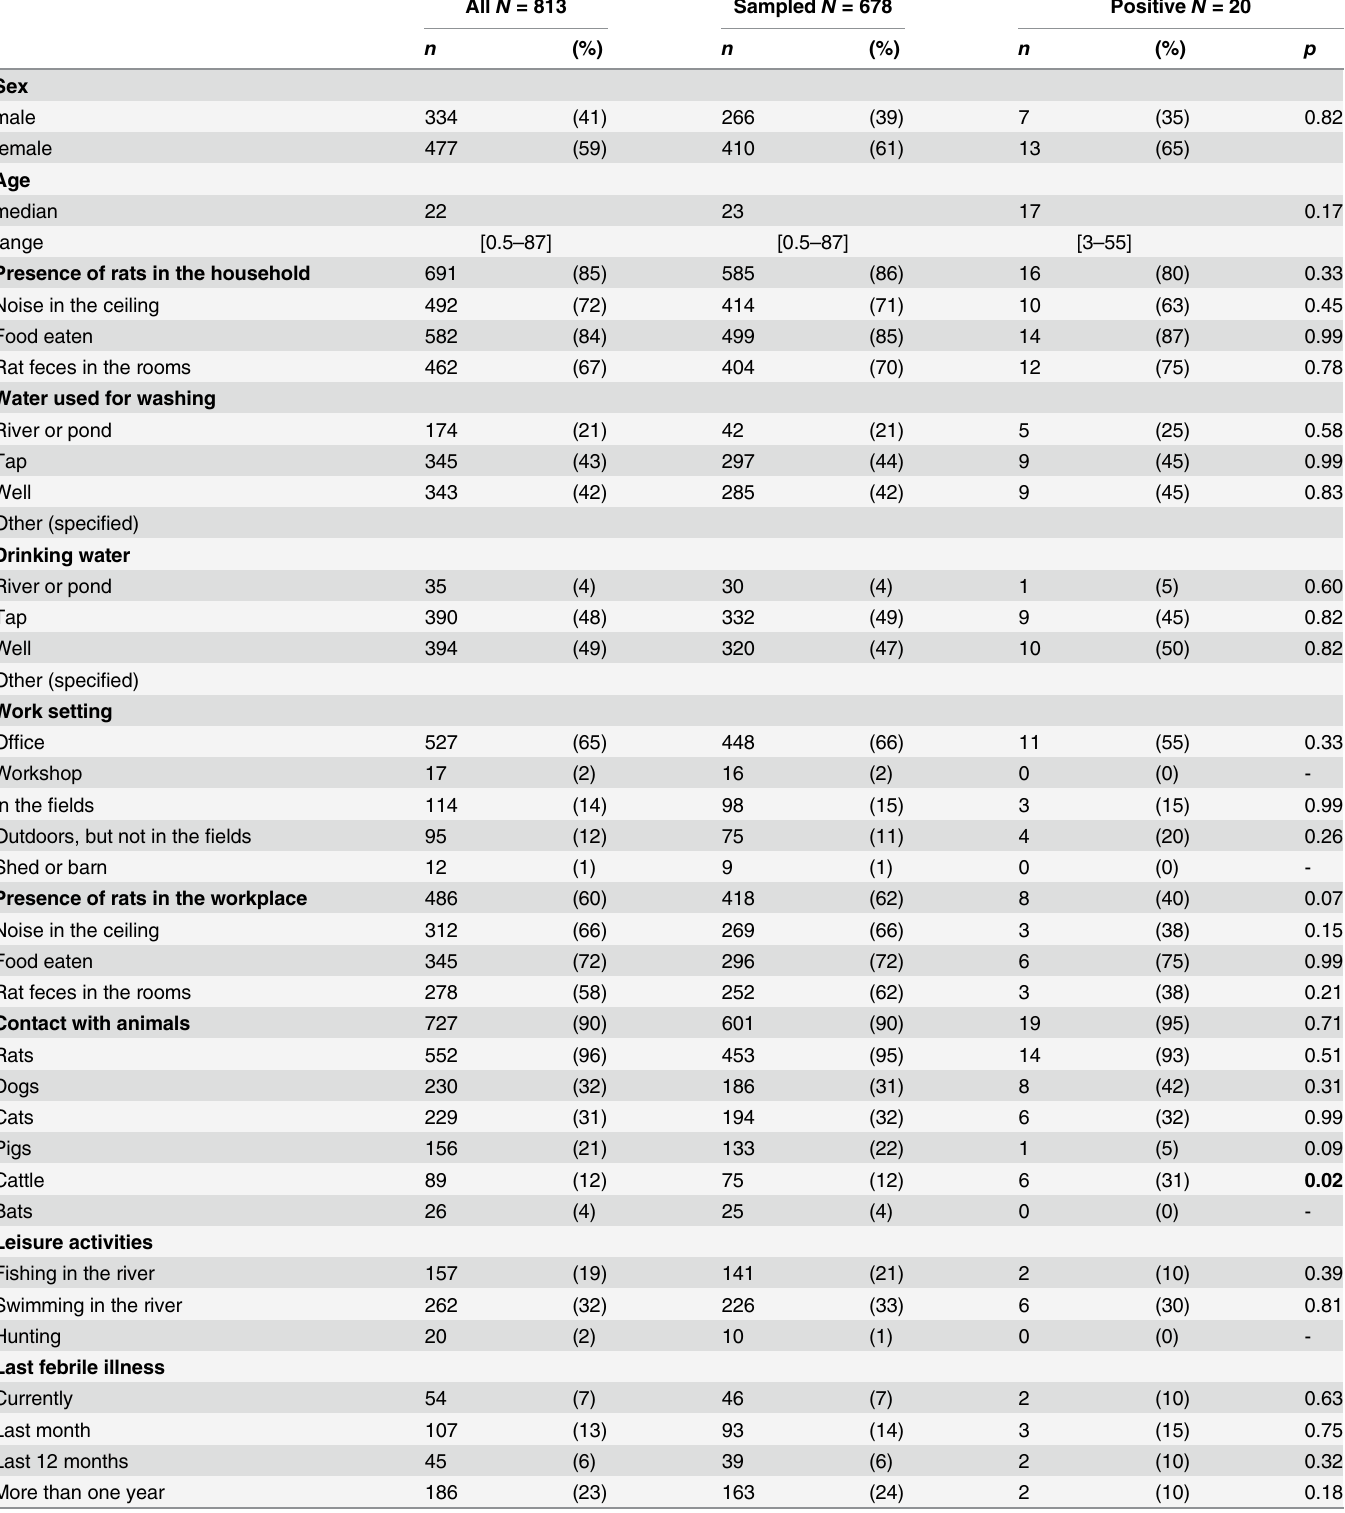
Table 1. Characteristics of the study population in Moramanga, 2011, and risk factors for